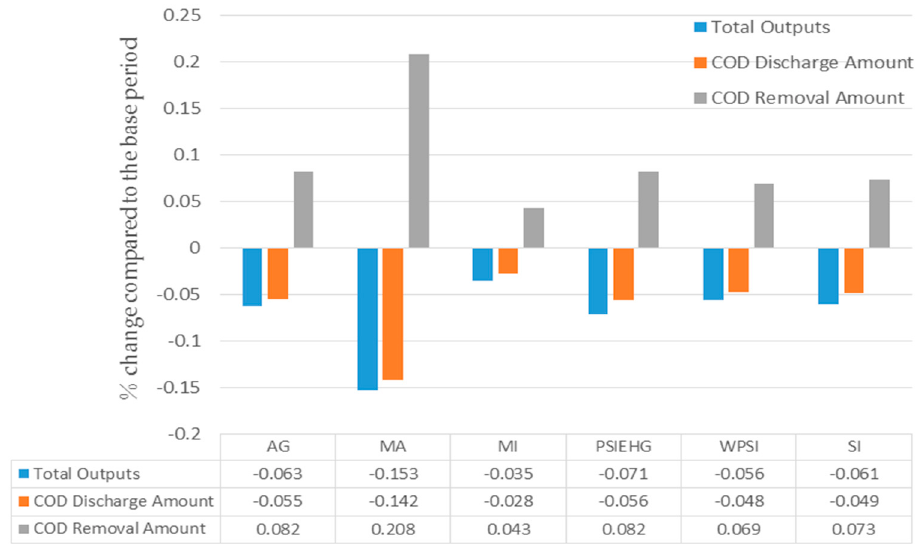
Figure 3. The impacts on different industries from increases in discharge fees.